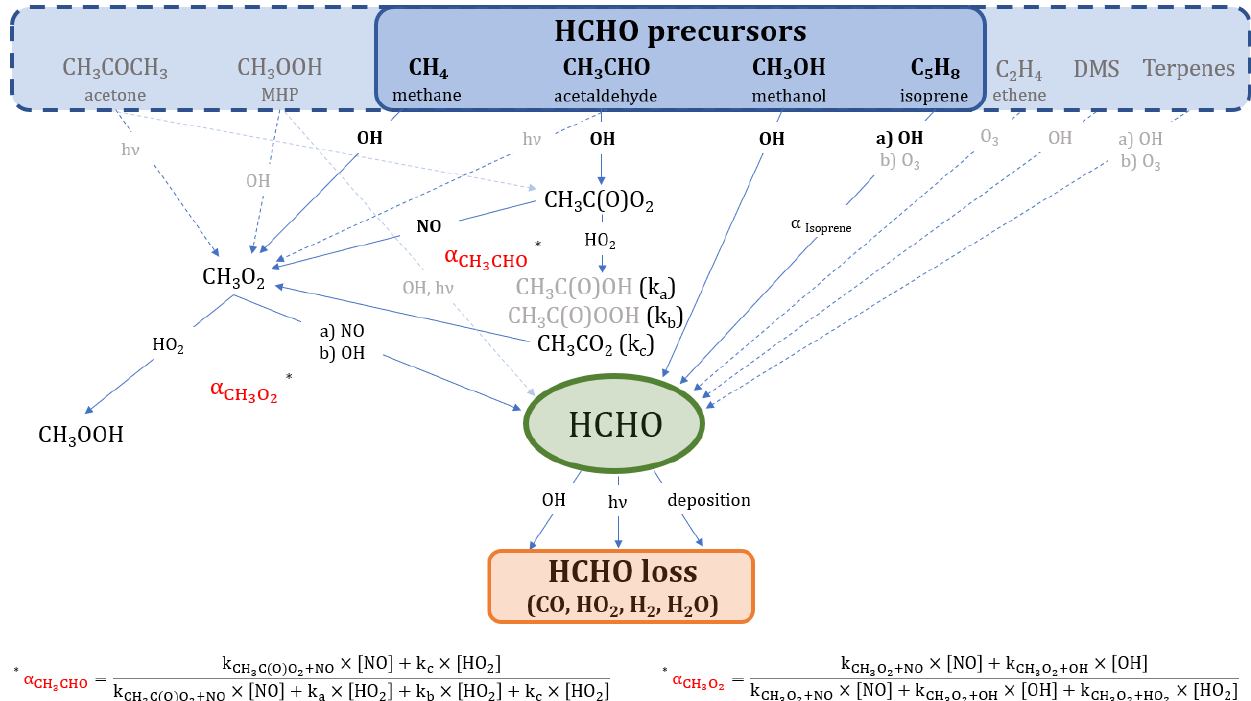
Figure 1. Overview of the chemical and photolytic reactions which lead to HCHO production and loss, considering the trace gases measured during the CYPHEX field experiment. The black and bold font identifies the species which contribute mainly ( ∼ 80%) to HCHO formation according to the findings in this study. For a better overview, we have omitted intermediate steps with a 100% yield which are, instead, described in the main